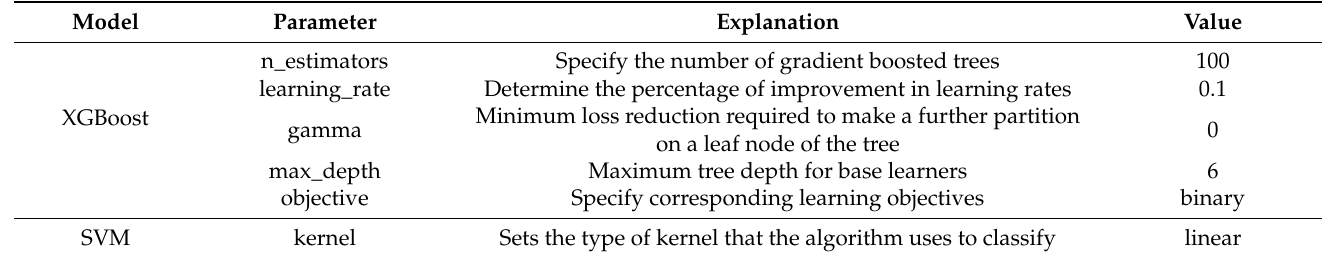
Table 2. Hyperparameters of the classification algorithm used in this